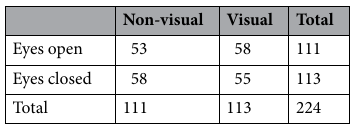
Table 1. Observations by treatment.